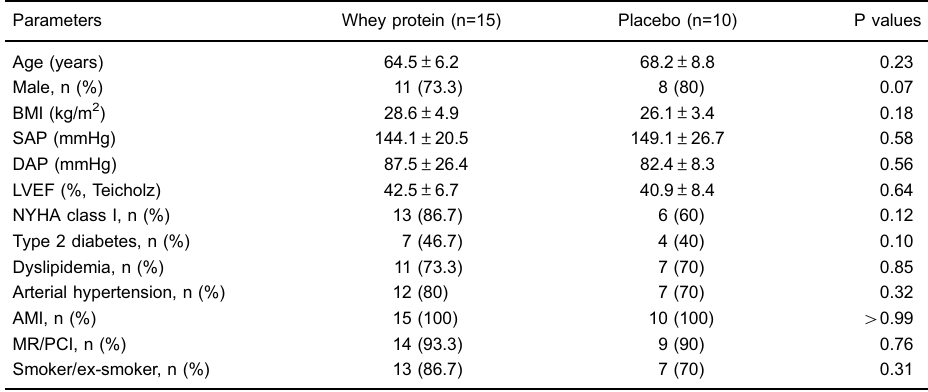
Table 1. Clinical characteristics of patients included in the groups of dietary supplementations with whey protein or placebo (12 weeks).